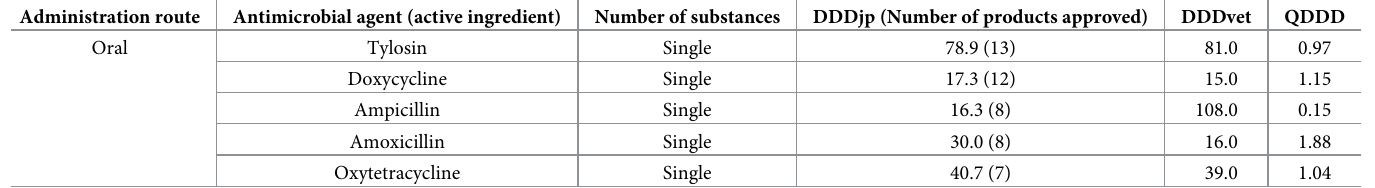
Table 9. Average daily doses (DDDjp) of the most frequently approved antimicrobial agents for use in poulry in Japan and their comparison with the values of the European Medicines Agency (DDDvet) based on calculated quotients (QDDD). Administration